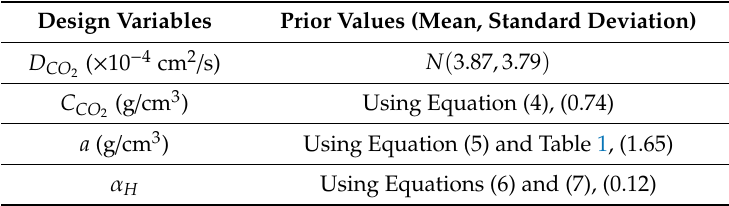
Table 5. Mean and standard deviation according to design variables.